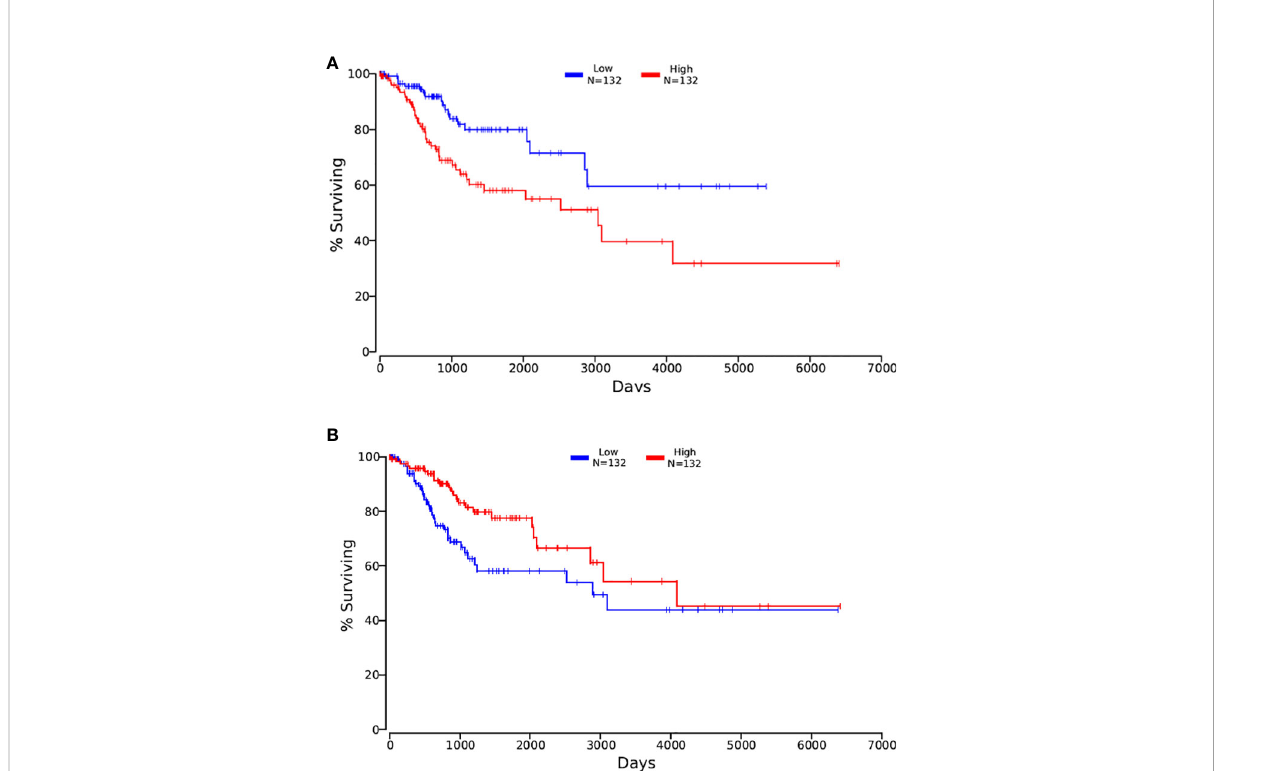
FIGURE 7 (A) the Kaplan-Meirer plot of ASPH in OncoLnc; (B) the Kaplan-Meirer plot of NKAPPl in